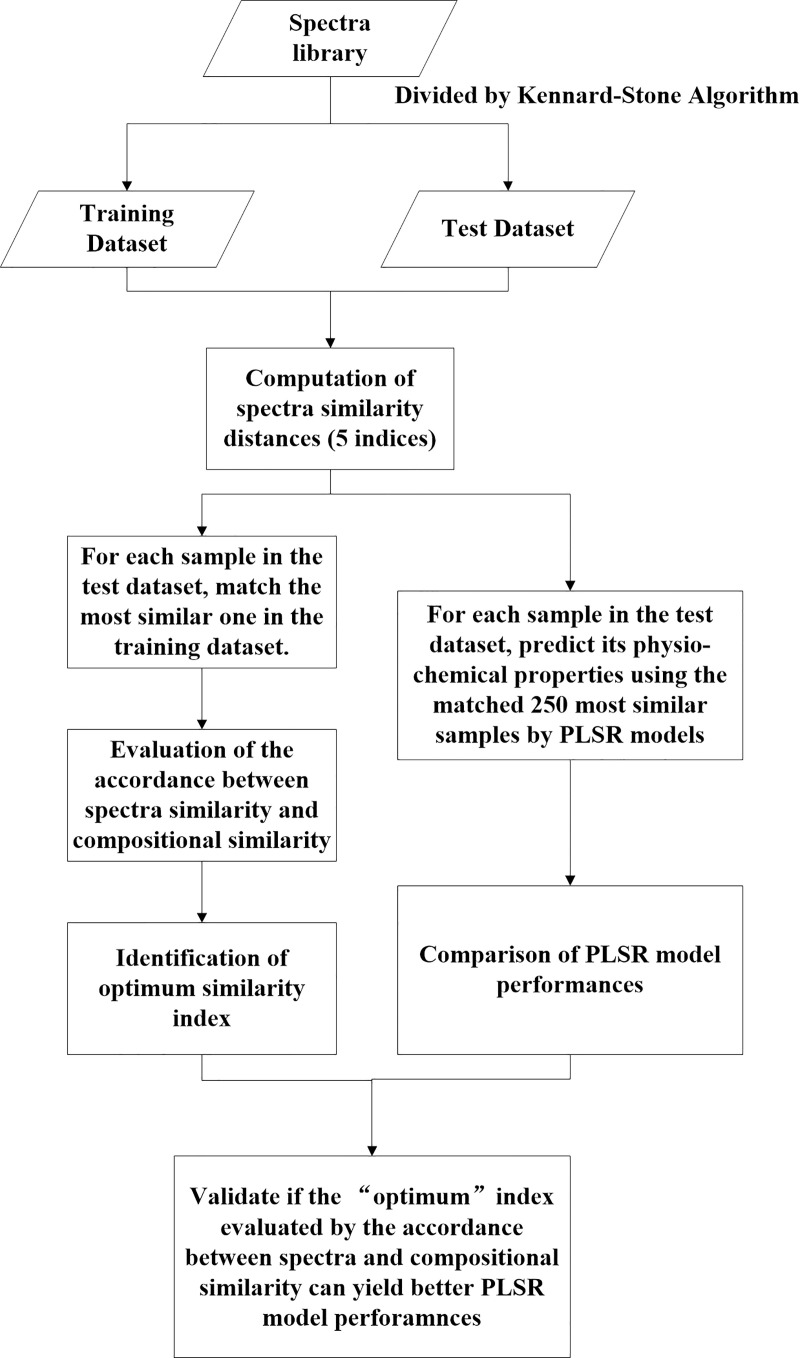
Flowchart of the methodology.